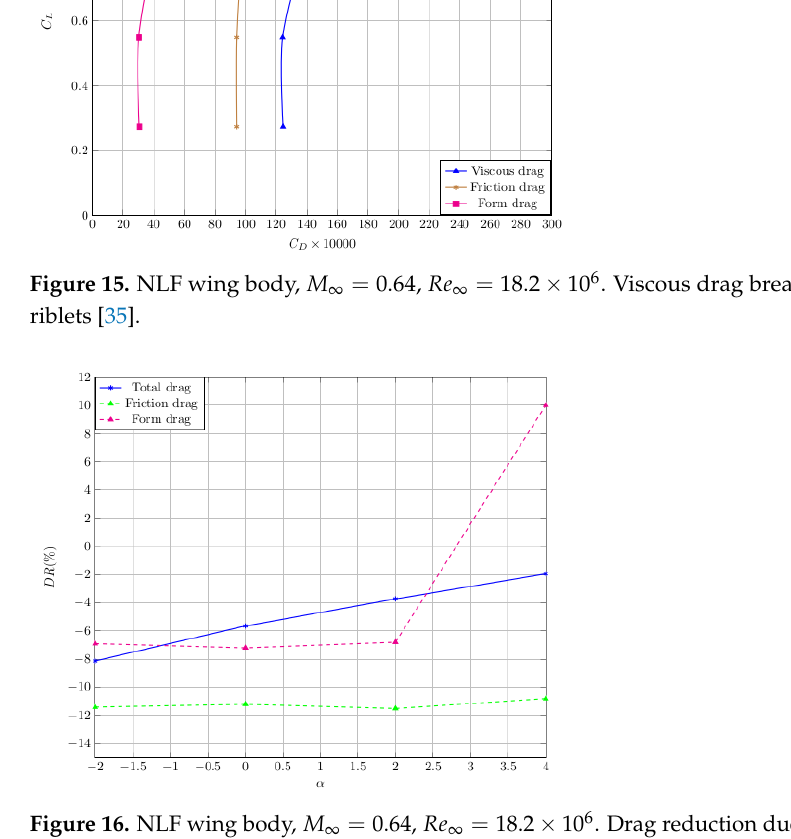
Figure 16. NLF wing body, M ∞ = 0.64, Re ∞ = 18.2 × 10 6 . Drag reduction due to riblets vs. angle of attack